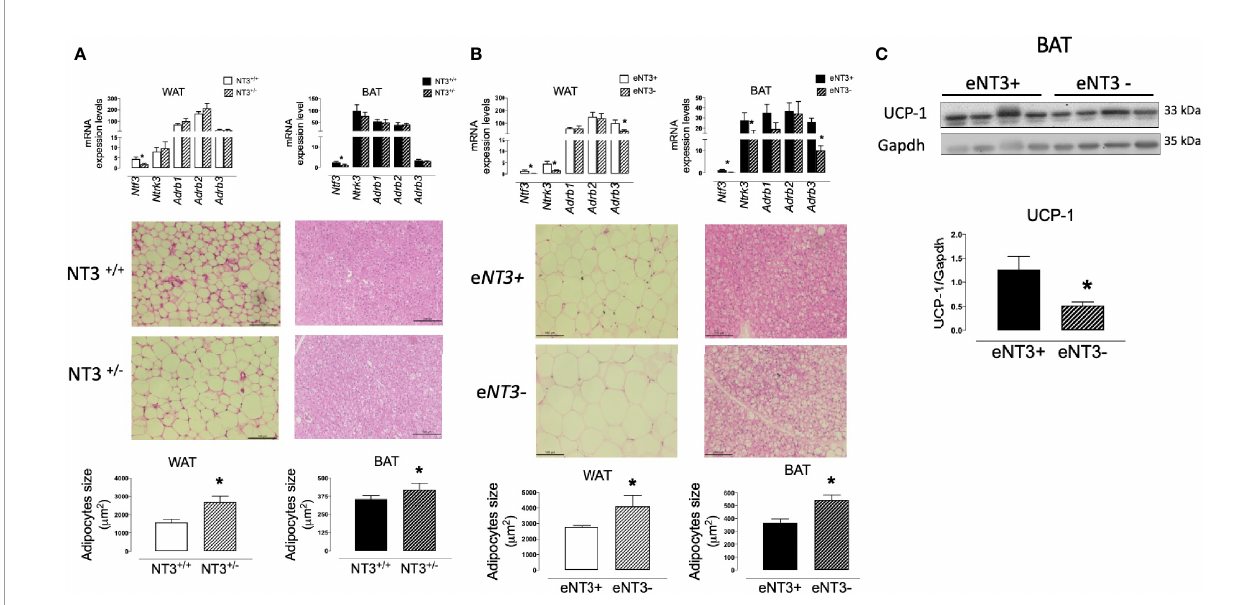
FIGURE 6 | De fi cient expression of NT3 is related to higher adipocyte size and lower UCP-1 expression in mice adipose tissue. mRNA levels of genes ( Ntf3 , Ntrk3, Adrb1, Adrb2 , and Adrb3) , paraf fi n-embedded sections of tissues stained with hematoxylin/eosin and quanti fi cation of the adipocyte size, in WAT and BAT from male NT3 +/+ and NT3 +/ − mice (A) and male eNT3- and their control littermates (eNT3+) (B), (C) Representative immunoblot and quanti fi cation of protein expression of UCP-1 in BAT from eNT3- and eNT3+ mice. Data are mean± SEM of 4 – 6 different animals per group. * P < 0.05 vs their littermates, Student ’ s t